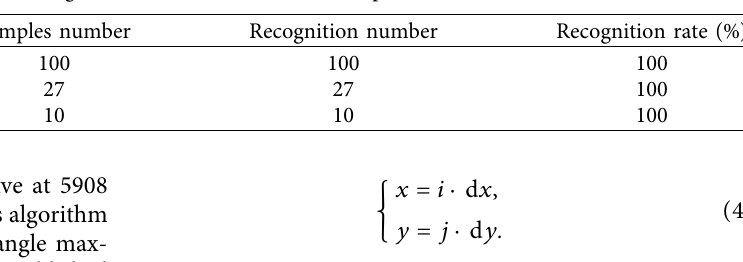
Figure 5: Presentation of the thinning Table 1: Digital recognition results of the contour map.